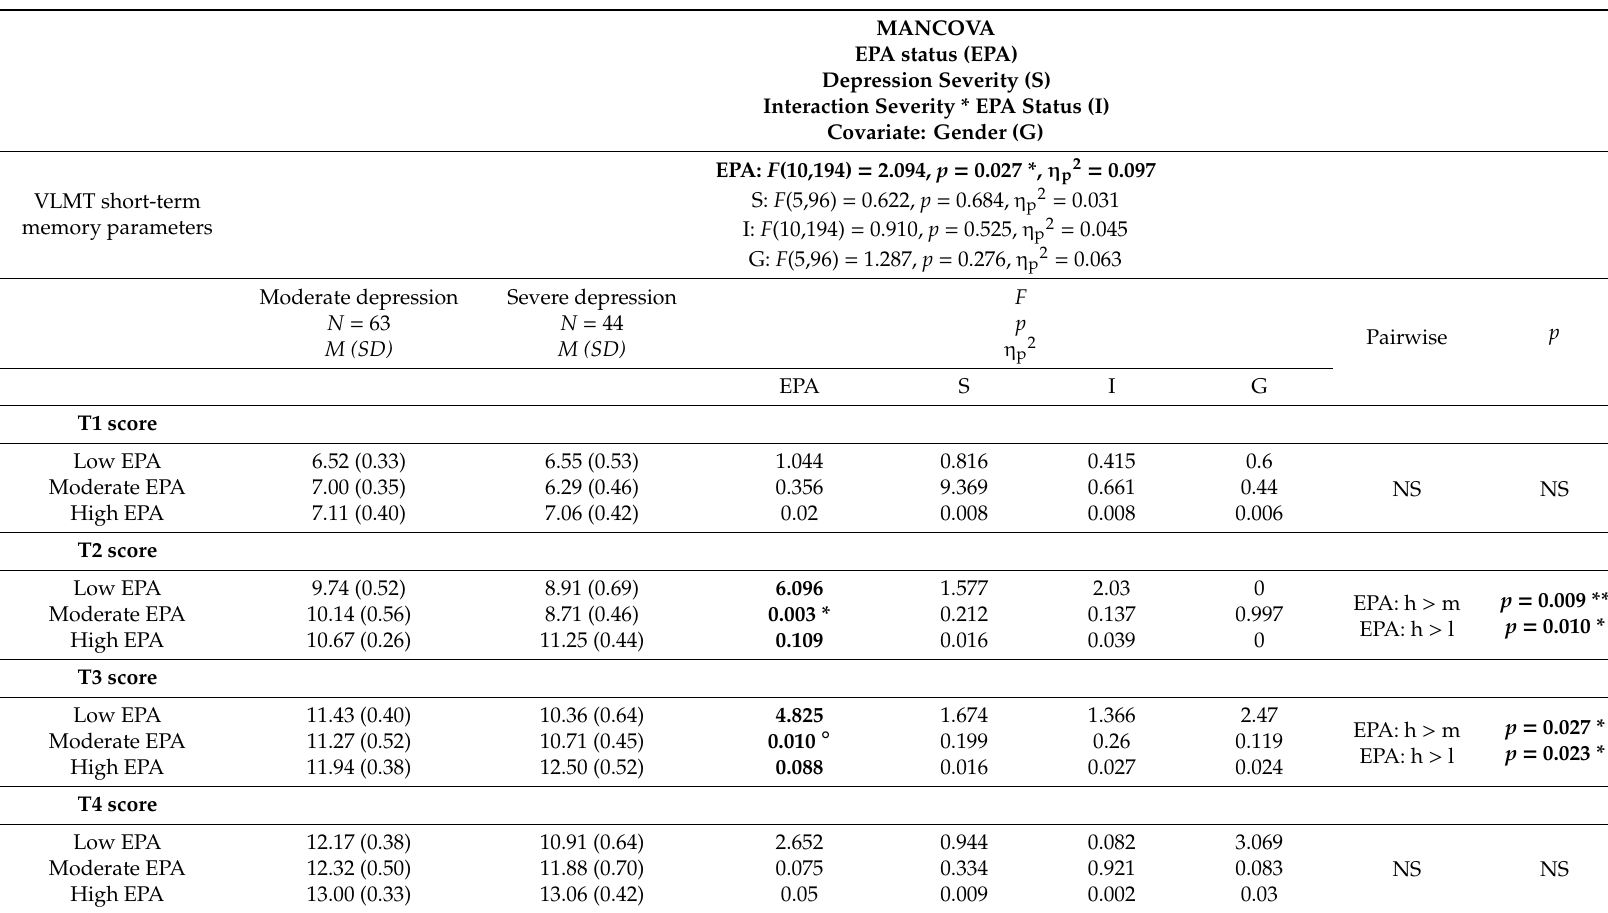
Table 3. Multivariate analysis of covariance (MANCOVA) and univariate analysis of covariance (ANCOVA) results for Verbaler Lern- und Merkfähigkeitstest (VLMT) and digit span parameters. EPA status and depression severity entered as factors and gender as a